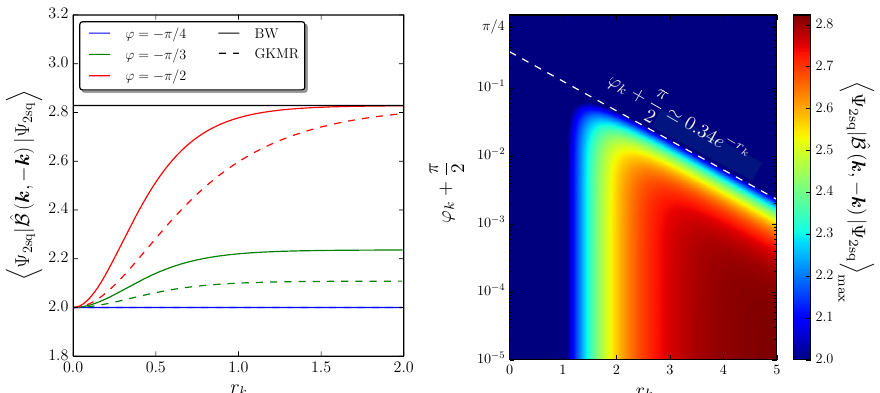
Figure 8. ( Left panel ): Mean value of the Bell operators for the BW (solid lines) and GKMR (dashed lines) fictitious spin operators versus the squeezing parameter r k , for different values of the squeezing angle ϕ k . We notice that Bell inequality is violated since same quantity for the Larsson fictitious spin operators. The value of the Bell operator mean is indicated by a color code where the maximum over (cid:96) is taken. If less than two, the color is blue; otherwise, the corresponding value is indicated by the color bar. Bell inequality is violated in some region of the squeezing parameter space corresponding to large squeezing and small squeezing